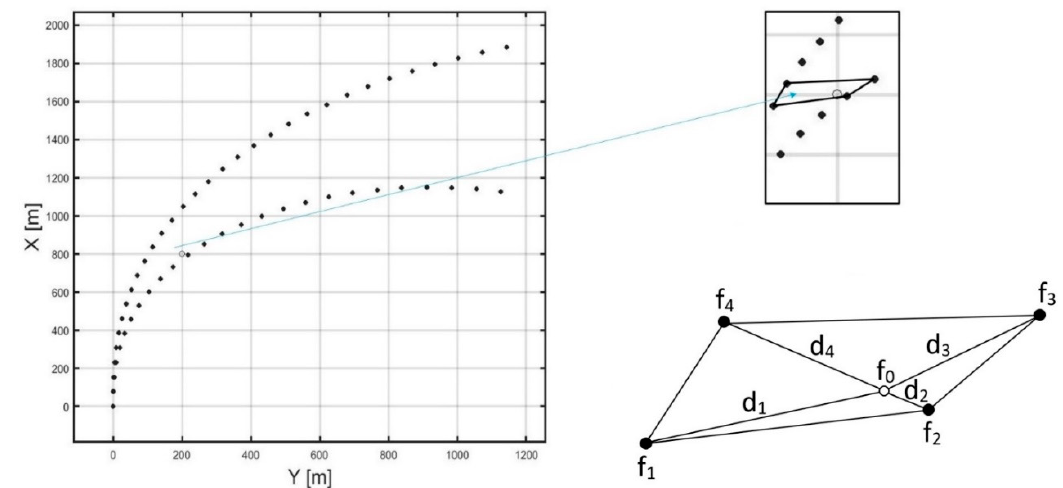
Figure 4. The visualized problem of the interpolation of the ship’s state vector for the specified point of the plane (the point for which the interpolation is to be made is marked with the tiny empty circle) where the measurements of the ship’s state vector are given at points resulting from the passages in each turning circle trial.